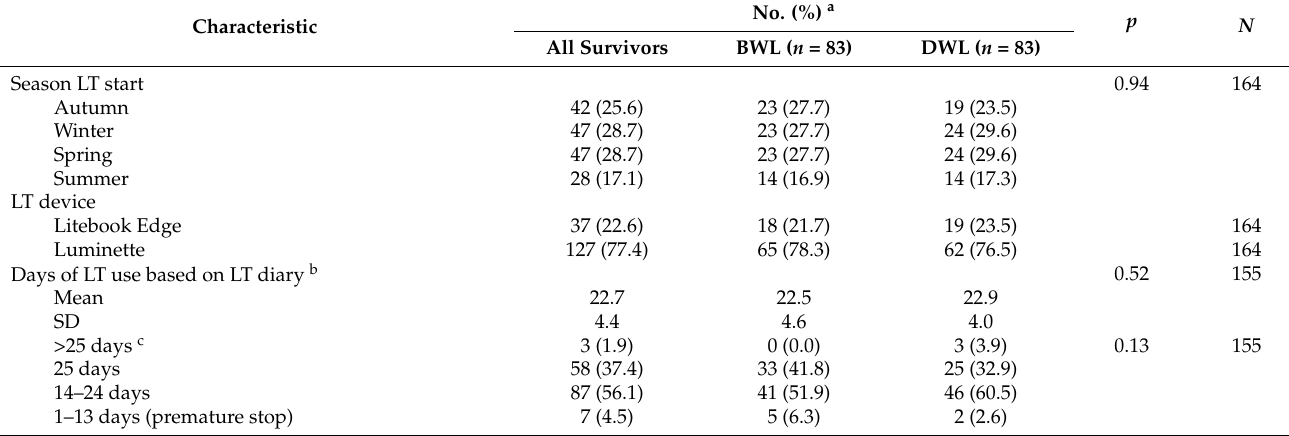
Table 3. Light therapy characteristics